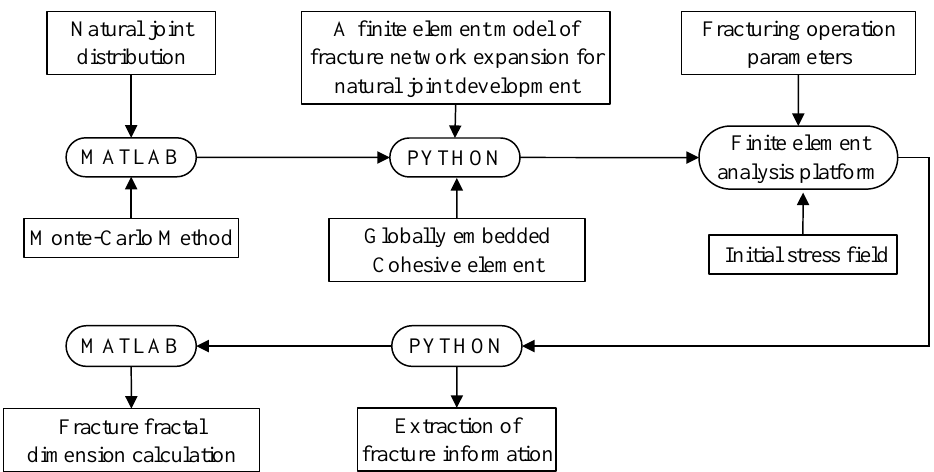
Figure 6. Modeling process of the fracture fractal propagation model of the developed CBM reservoir based on fractal natural joints.